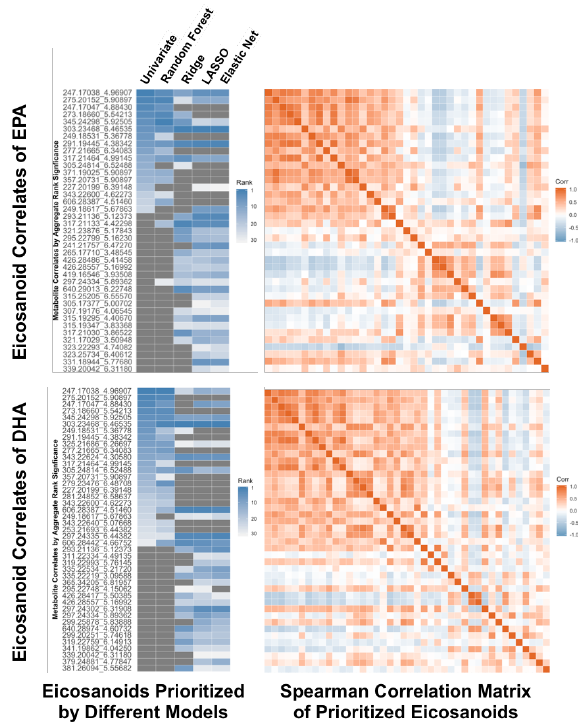
Figure 3. Using multiple statistical methods to evaluate results in a real-life application involving analyses of large cohort metabolite data. We related a panel of bioactive lipid molecule metabolites (i.e., eicosanoids) to putative derivative substrates (i.e., eicosapentaenoic acid (EPA) and docosahexaenoic acid (DHA)), which were considered in all analyses as the outcomes of clinical relevance and interest. We used multiple different statistical methods and compared results. Metabolites are denoted by mass-to-charge ( m / z ) ratio and retention time (rt, in minutes) using the m / z _rt convention, and are listed in rank order for each outcome (EPA or DHA) according to performance metrics provided by each